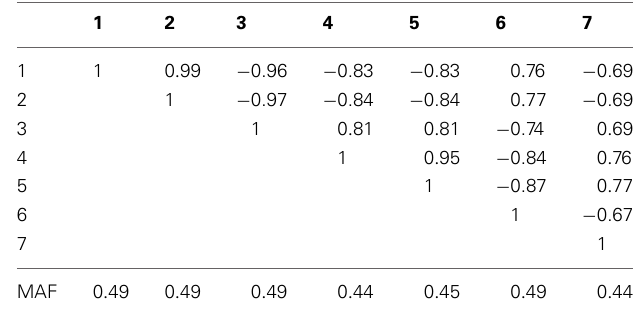
Table 2A | Linkage disequilibrium between SNPs measured by Pearson’s correlation coefficient along with the SNP minor allele frequencies in a seven marker LD block on chromosome 10, simulated based on genome scans of samples from the Lung Health Study.